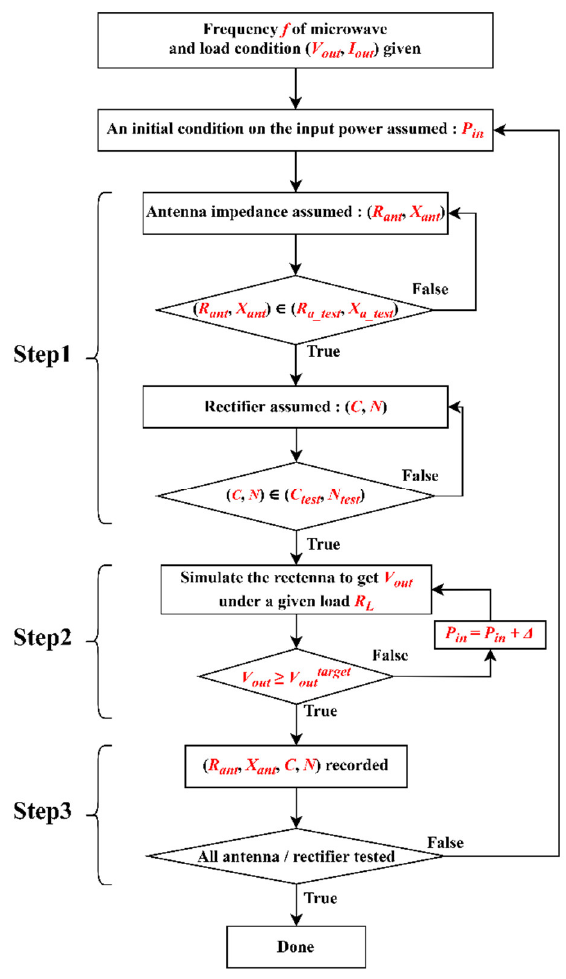
Figure 3. A design flow with multiple feedback loops in the forward direction.